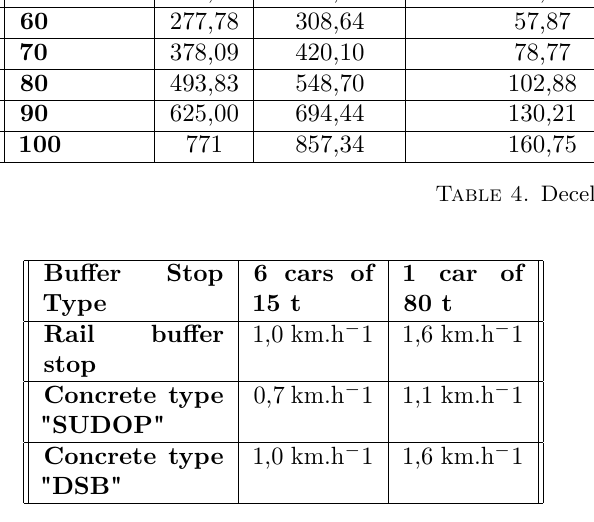
Table 5. Resistances of buffer stops used in Czech Republic [1] Figure 1. Example of hydraulic buffer stop